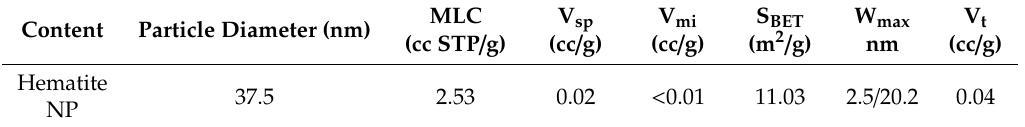
Table 3. Adsorption parameters for the Hematite nanoparticle (Hematite NP) samples studied. Content Particle Diameter